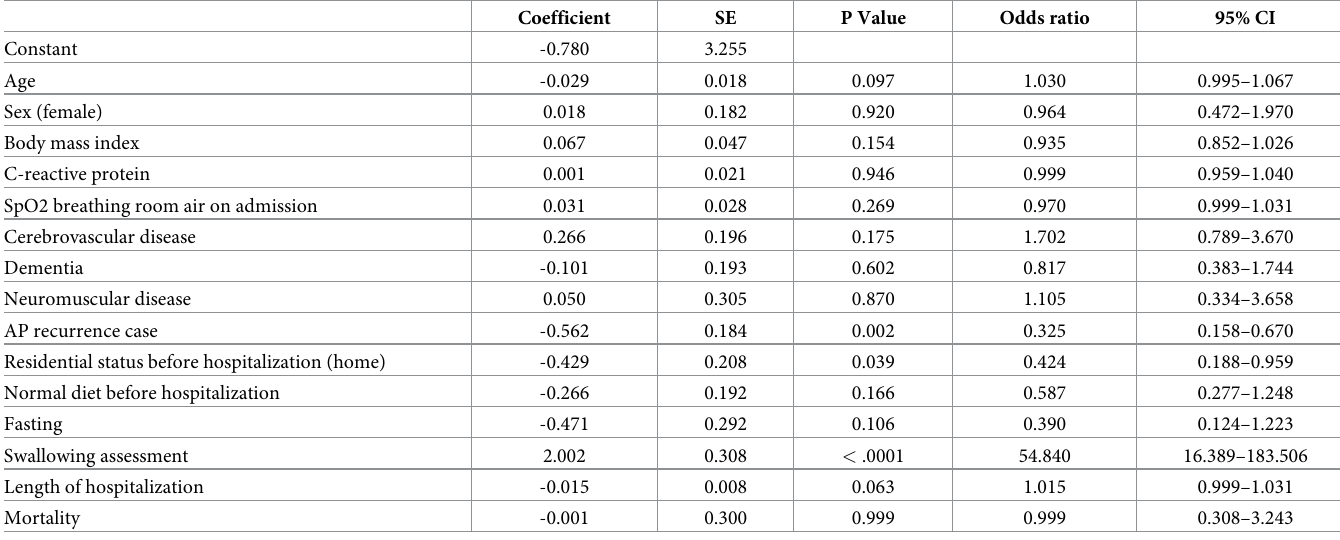
Table 4. Factors characterizing swallowing intervention group by logistic regression